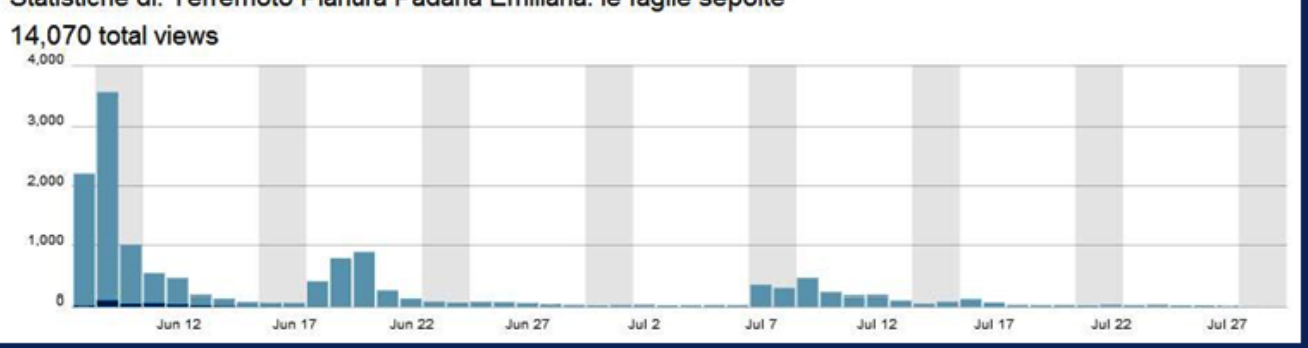
5.1 earthquake in the Po Plain region. On that day, there L